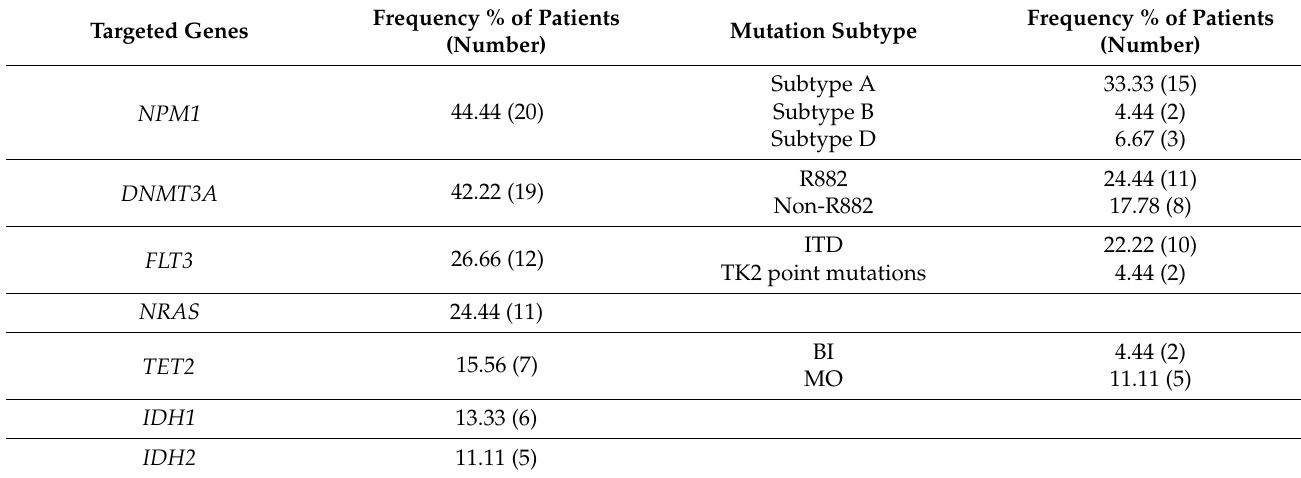
Table 1. Frequency of mutated genes in our mutational screening group (45